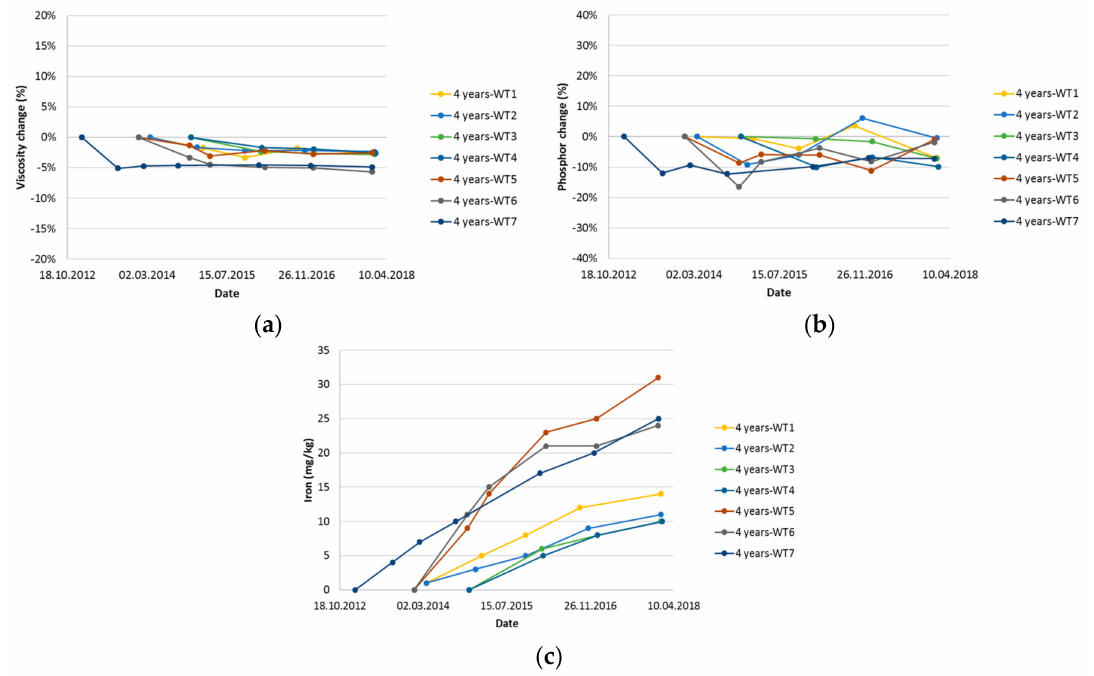
Figure 8. Trend analysis for the four-year turbine group with PAO I. ( a ) Changes in the kinematic viscosity; ( b ) changes in the phosphorus content measured by the ICP method; ( c ) iron content measured by the ICP